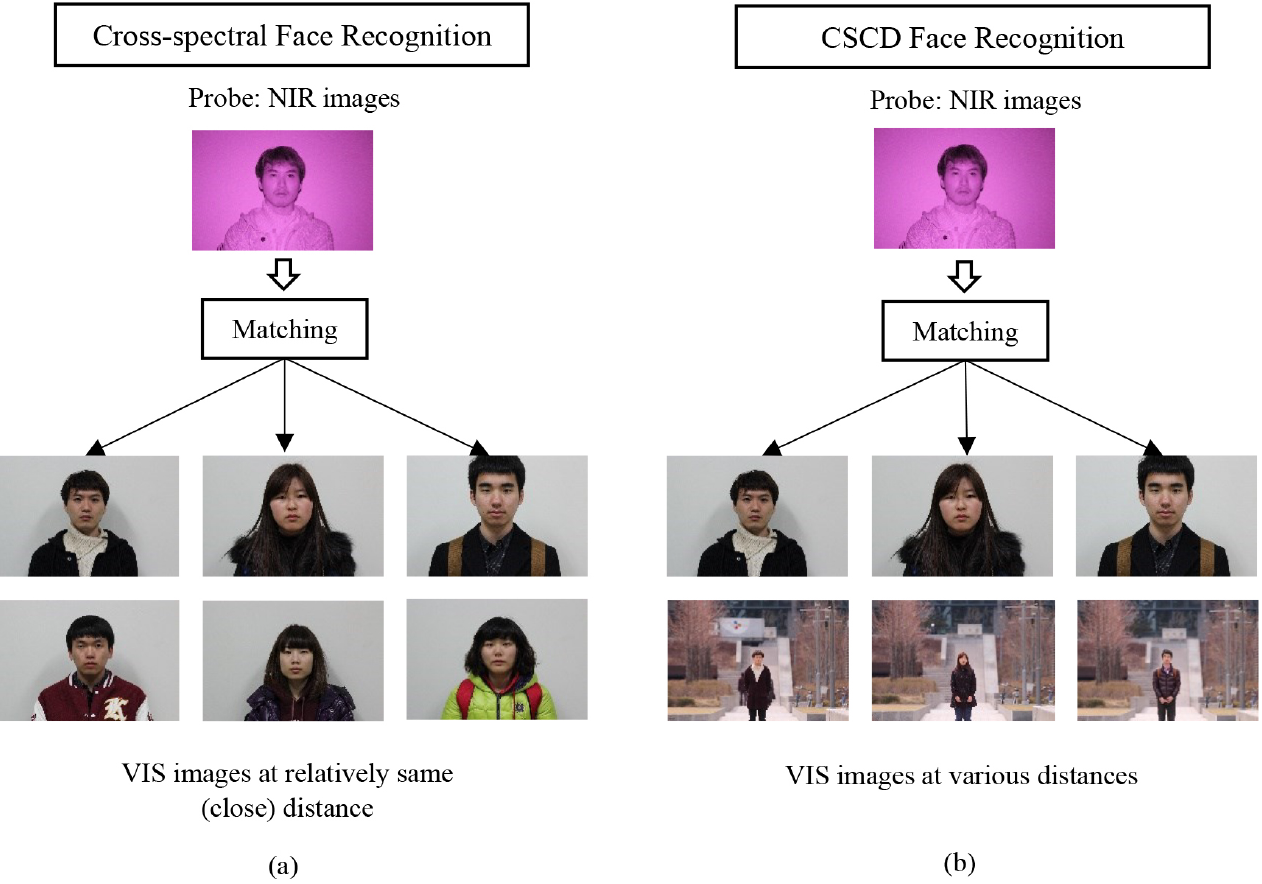
Figure 1. ( a ) Cross-Spectral (CS) and ( b ) Cross-spectral Cross-Distance (CSCD) Face Recognition. Zuo et al. [32] evaluated the cross-spectral face matching between the face image captured under the spectral band and those captured under the SWIR spectral band. Local Binary Pattern (LBP) and Generalized Local Binary Pattern (GLBP) features were used for the encoding process. An adaptive score normalization method was used to improve the recognition performance. The approach resulted in a better recognition performance. However, the improved performance highly depends on a score level fusion